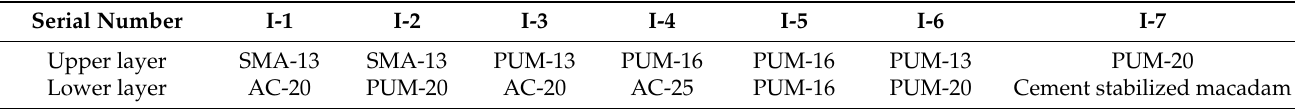
Table 4. Composite specimens without adhesive layer.